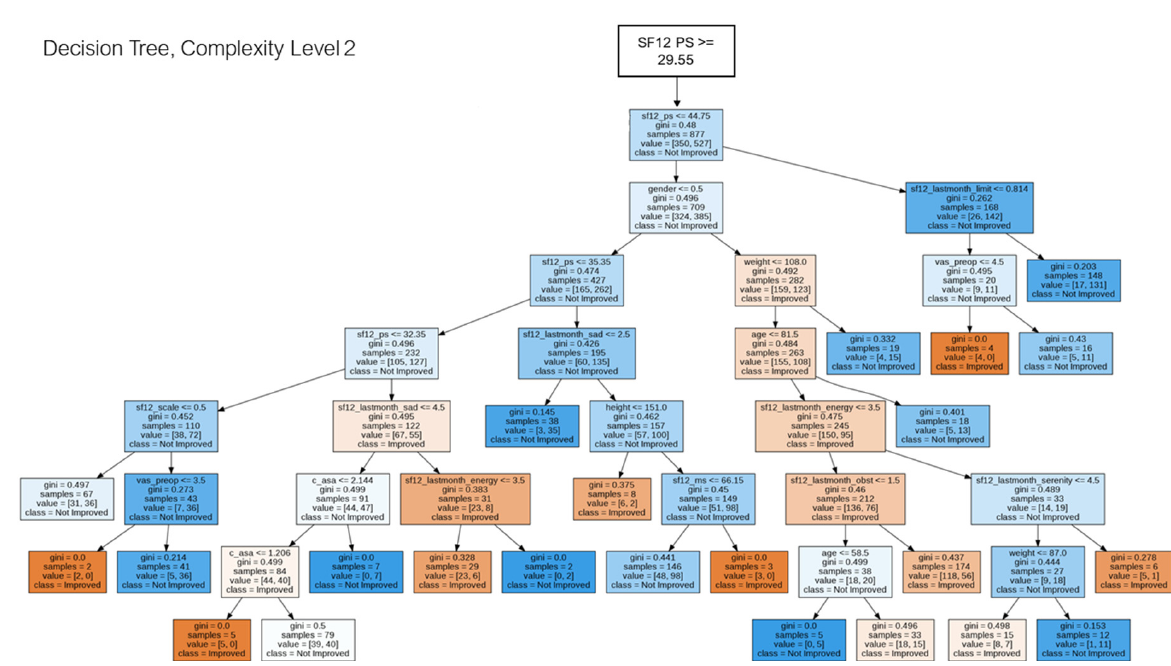
Figure A1. Decision Tree visualization (sub-tree), high